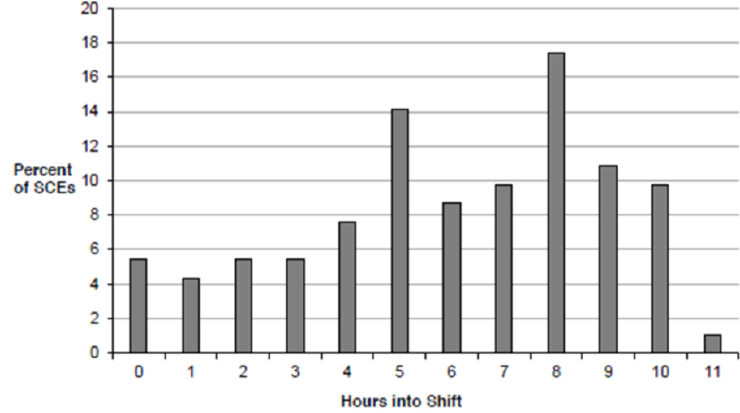
Figure 4. Percent of SCEs by number of hours into shift. Table 2. Summary of safety-critical events (SCEs) by participant.